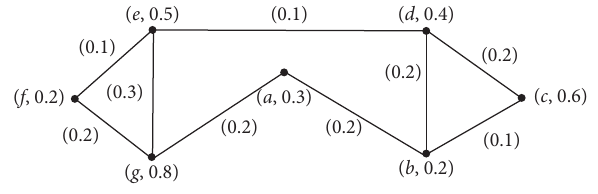
Figure 9: Fuzzy graph G � ( J , K ) .